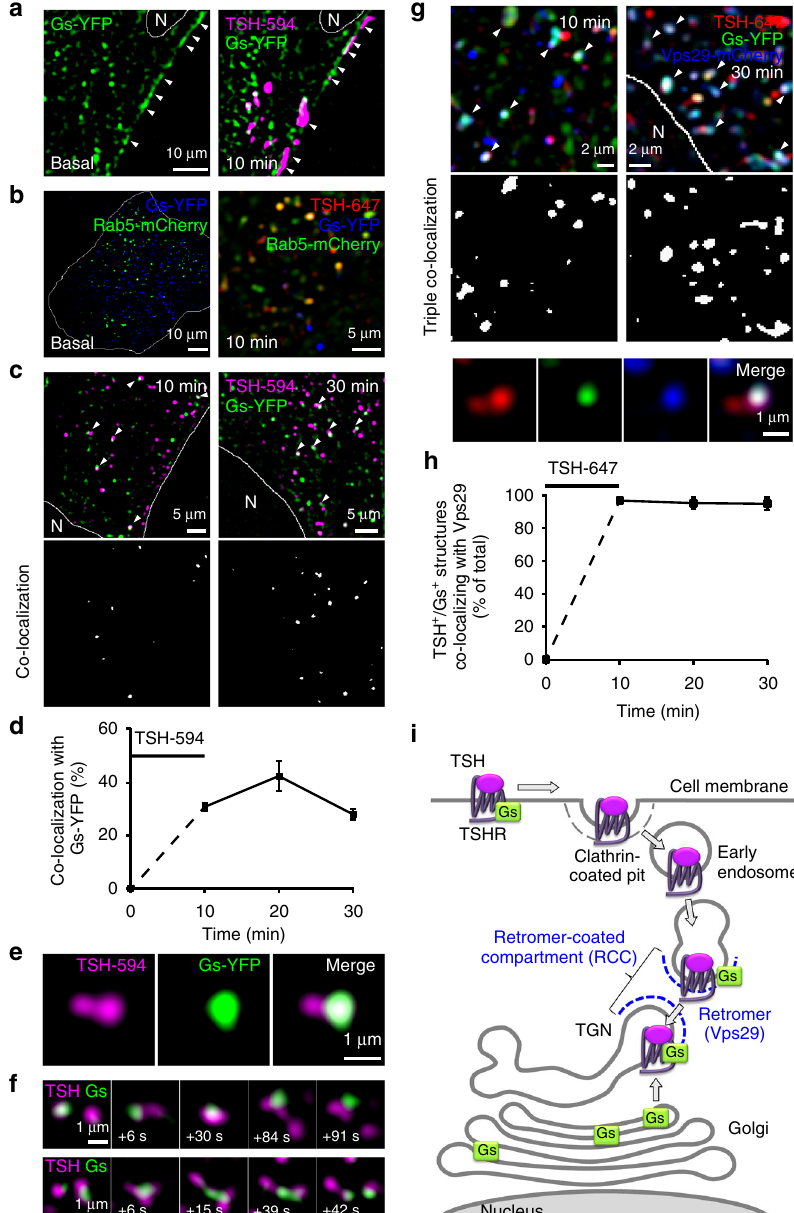
Fig. 2 Internalized TSH/TSHRs meet the G s -protein at the retromer-coated compartment (RCC) associated with the TGN. Primary mouse thyroid cells were cotransfected with different combinations of G s -YFP and/or subcellular markers, followed by stimulation with fl uorescent TSH (TSH-594 or TSH- 647) for 10 min to visualize internalized TSH/TSHR complexes. Shown are images at the indicated time points from beginning of stimulation. a Co- localization between TSH-594 and transfected G s -YFP at 10 min. The focus in the images shown in a was speci fi cally set to also visualize TSH and the G s - protein at the plasma membrane (arrowheads). b Co-localization between TSH-647, G s -YFP and the early endosome marker Rab5-mCherry. Note the absence of triple co-localization after TSH stimulation. c Co-localization between TSH-594 and G s -YFP. TSH is co-localizing with the G s -protein on subdomains of tubulovesicular structures concentrated around the nucleus (arrowheads). d Quanti fi cation showing the percentage (mean ± s.e.m.; n = 10 cells) of TSH-containing structures co-localizing with G s -YFP over time, calculated from images like those in c . e Enlarged view of a typical elongated membranous structure, showing presence of the G s -protein on only one side and TSH on both. f Image sequences showing polarized fusion/splitting events among TSH- and G s -protein-containing structures. Time is given relative to the fi rst image. g Simultaneous visualization of TSH-647, G s -YFP and Vps29-mCherry, used to localize the retromer complex. Structures analogous to those reported in c were observed (arrowheads). Bottom Enlarged view of a typical elongated membranous structure demonstrating the presence of retromer on the G s -positive subdomain. h Quanti fi cation showing the percentage (mean ± s.e.m.; n = 4 cells) of structures containing both TSH-647 and G s -YFP co-localizing with Vps29-mCherry over time, calculated from images like those in g . i Schematic view of the results. Where appropriate, cell edges and nucleus (N) are marked in white. Data in a – c and g are representative of 3, 3, 5 and 3 independent experiments, respectively